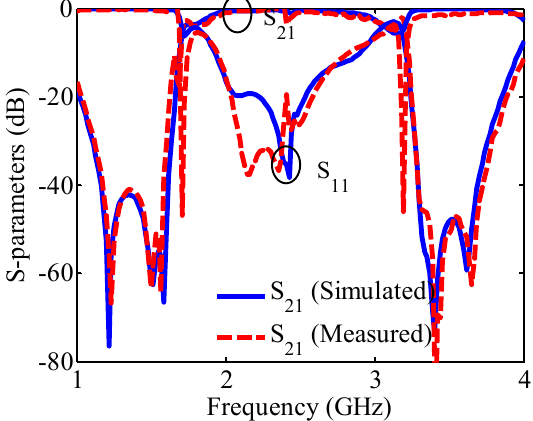
Figure 12. Simulated and measured S -parameters results of reconfigurable bandwidth BPF with 3 λ g / 4 open-ended stubs for wideband state.